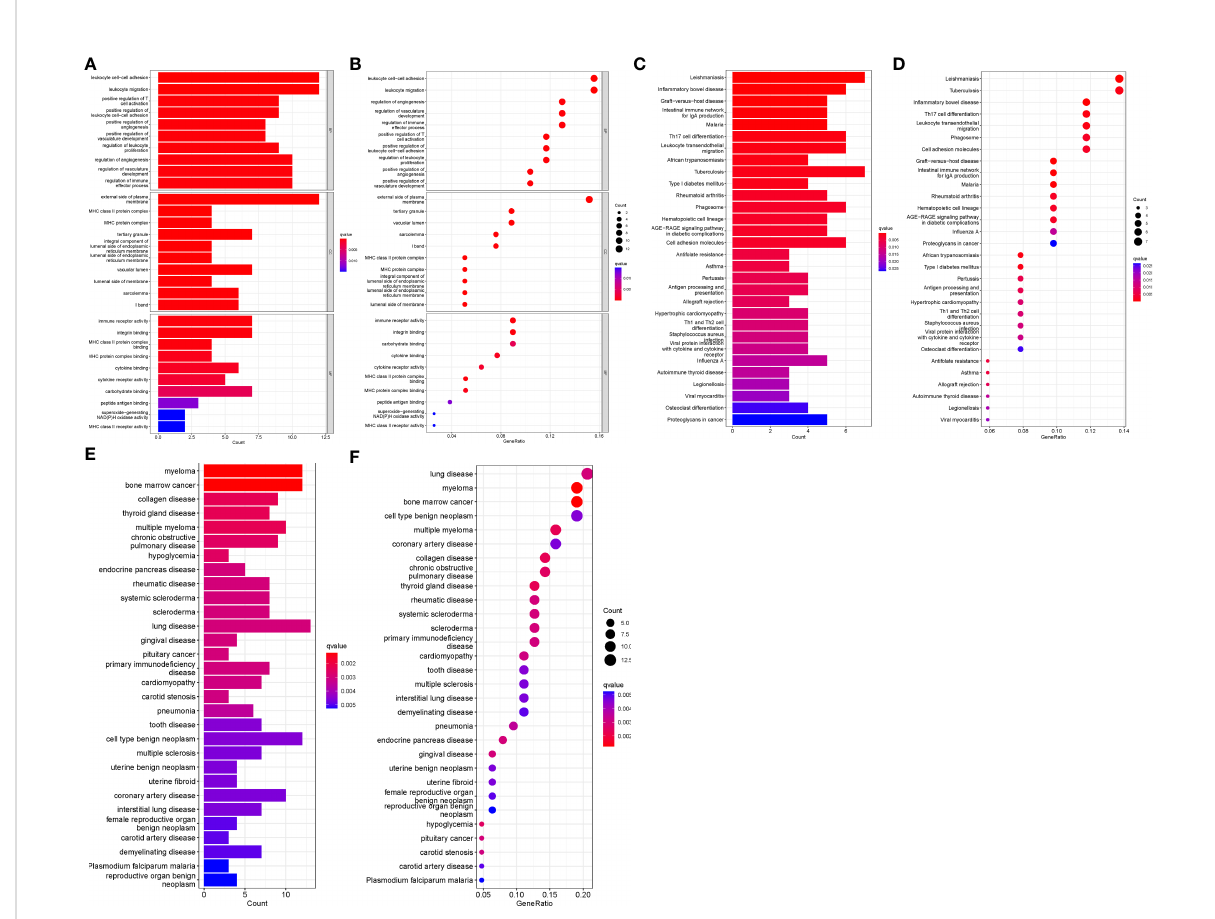
FIGURE 2 GO, KEGG and DO enrichment analyses. (A) Histogram of GO analysis. Enrichment signi fi cance increases with red color intensity. (B) Bubble plot representing GO analysis. Bubble size is proportional to the number of enriched genes. Red bubble color intensity increases with enrichment signi fi cance. (C) Histogram of KEGG analysis. (D) Bubble diagram representing KEGG analysis. (E) Histogram of DO analysis. (F) Bubble plot representing DO